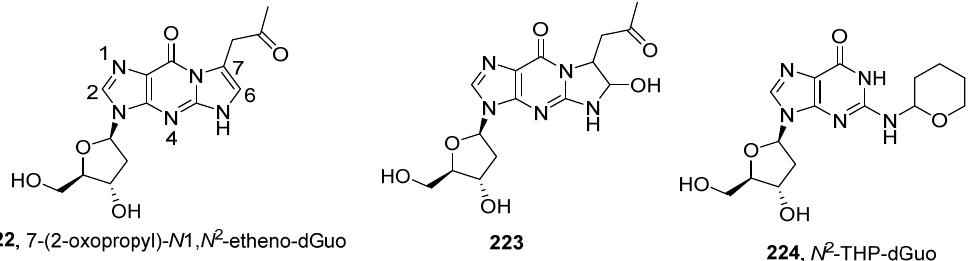
Figure 14. Structures of DNA adducts formed by NPIP